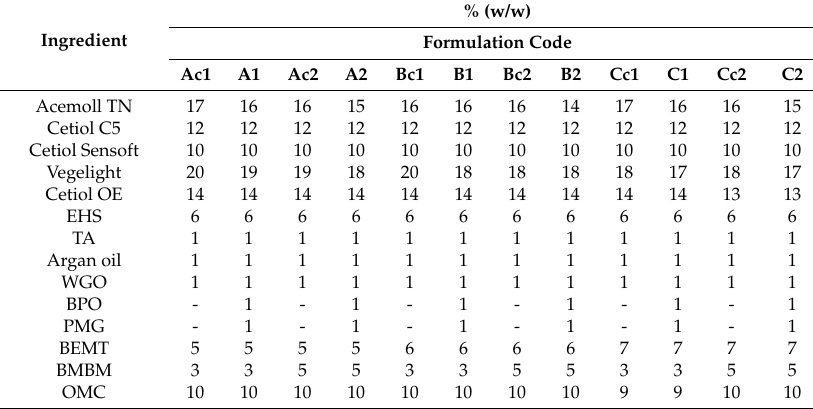
Composition (% (w/w)) of sunscreen oil-based vehicles. EHS: ethylhexyl stearate; TA: tocopheryl acetate; WGO: wheat germ oil; BPO: shea oil; PMG: pomegranate seed oil; BEMT: bis-ethylhexyloxyphenol methoxyphenyl triazine; BMBM: butyl methoxydibenzoylmethane; OMC: ethylhexyl